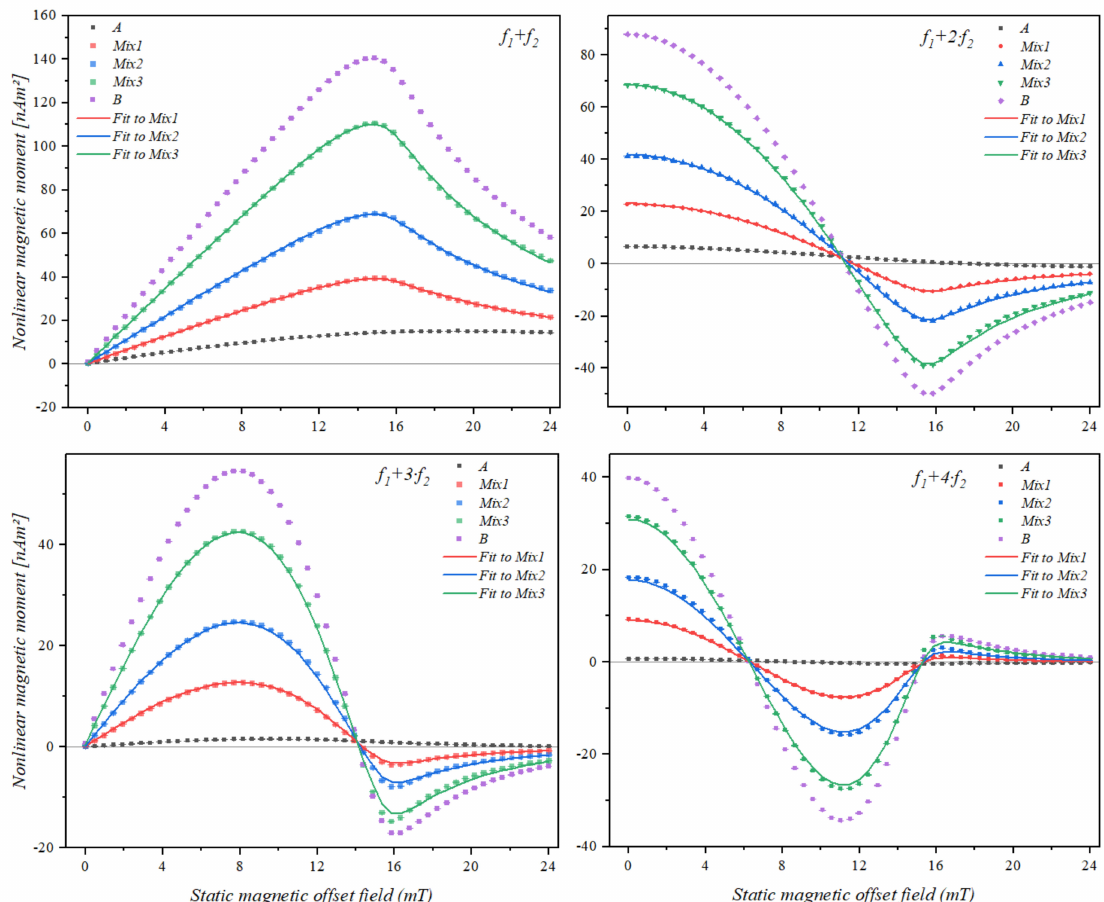
Figure 4. Nonlinear magnetic moment trace (mean and standard deviation within point size) of samples made from a mixture of two different types of magnetic beads over a static magnetic offset field range of 0 to 24 mT, for mixing frequencies f 1 + f 2 , f 1 + 2 · f 2 , f 1 + 3 · f 2 and f 1 + 4 · f 2 . A and B represent the samples containing pure bead A and pure bead B, respectively. Samples Mix1 to Mix3 contain different ratios of the two beads, they have been analyzed using the QP algorithm for determination of the